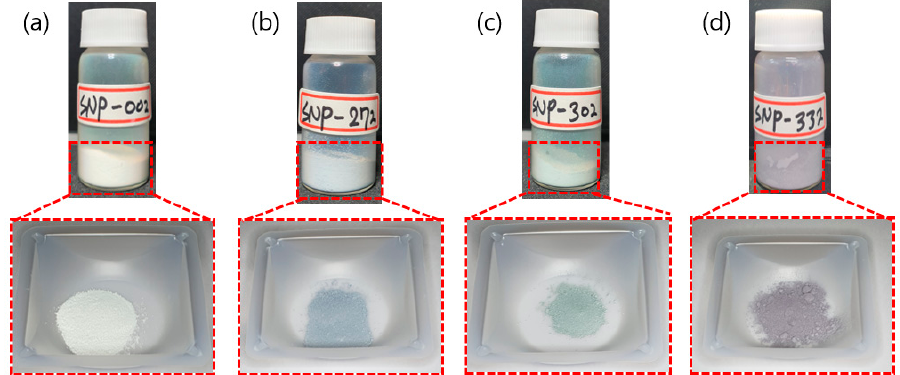
Figure 6. Photographs of the silica powders: ( a ) No added phenol-formaldehyde resin (Case 1); ( b ) 0.027 g of added phenol-formaldehyde resin (Case 2); ( c ) 0.030 g of added phenol-formaldehyde resin (Case 3); ( d ) 0.033 g of added phenol-formaldehyde resin (Case 4).